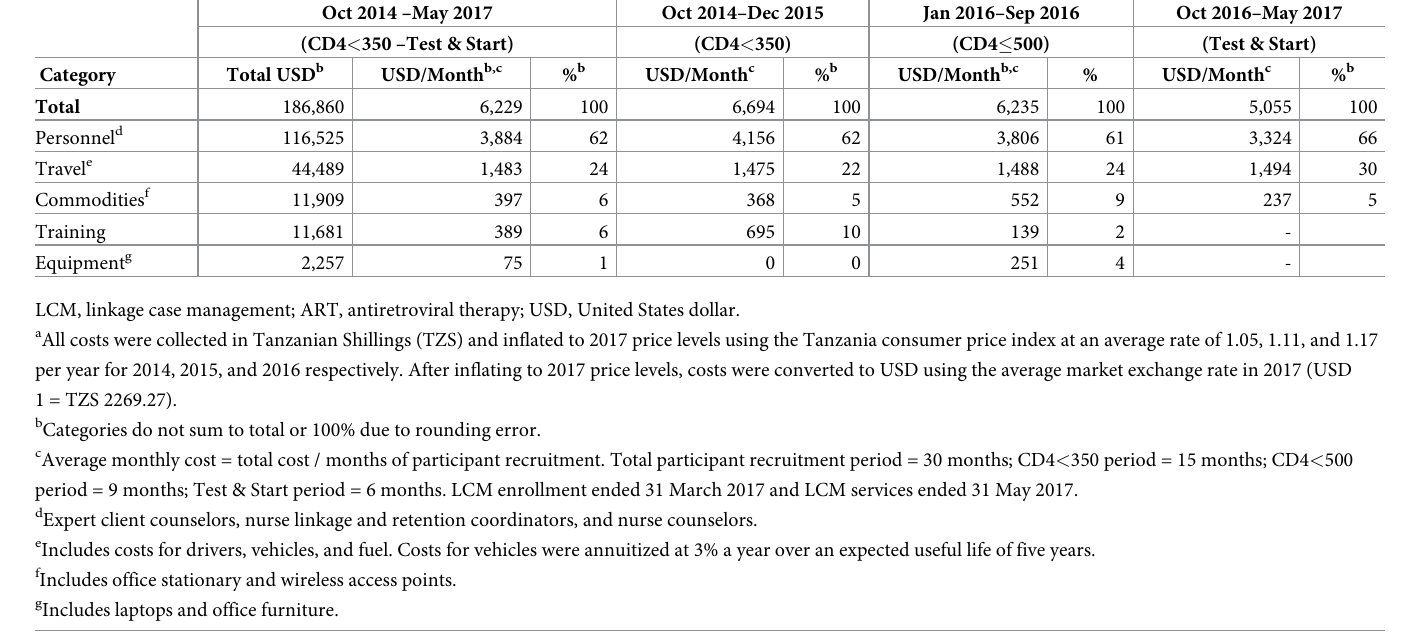
Table 5. Total and average monthly LCM program costs (USD), by category and ART eligibility period, Bukoba Combination Prevention Evaluation, Bukoba Tan- zania, 2014–2017. a . All